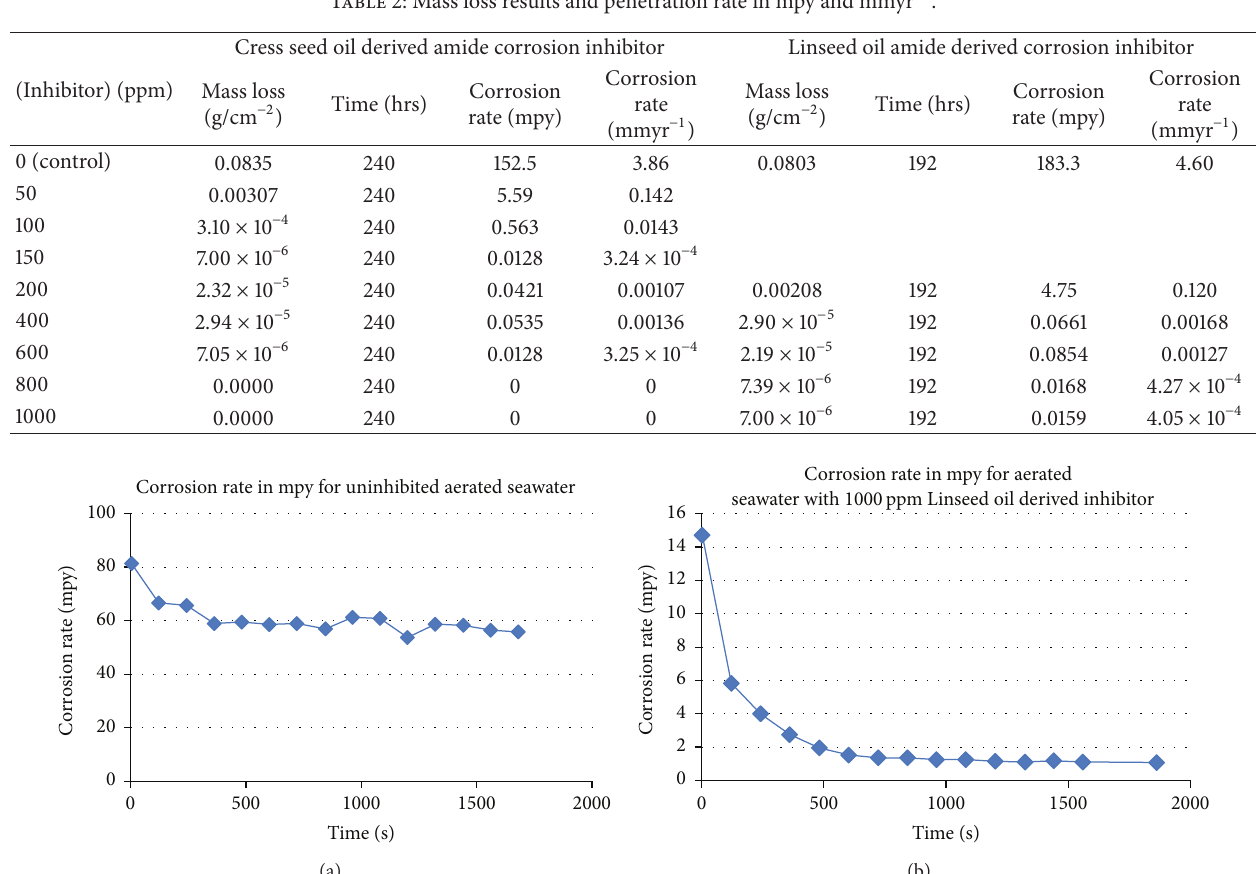
Table 2: Mass loss results and penetration rate in mpy and mmyr −1 .